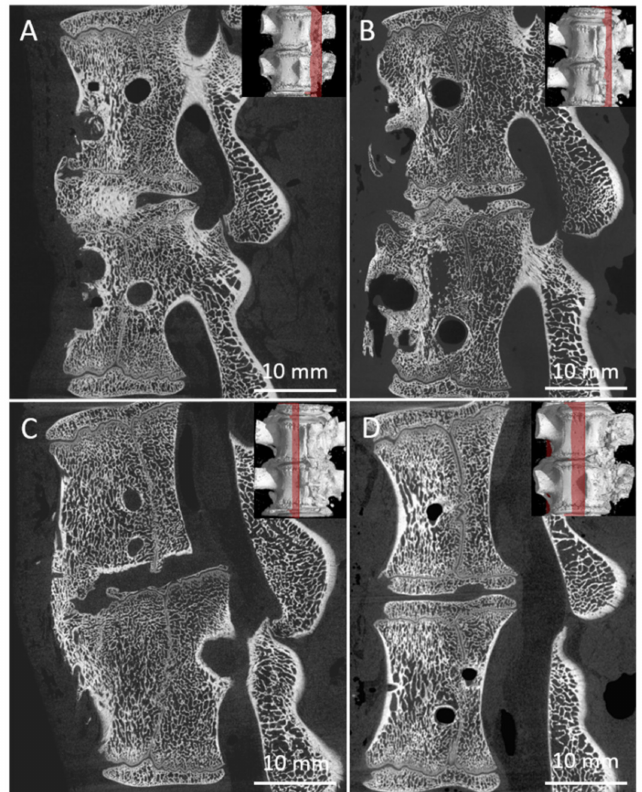
Figure 8. Examples of bone graft samples sorted into groups according to the quality of the fusion Grade I, II, III, IV, respectively. ( A ) fusion is visible and entirely joins the vertebra in the area of the bone graft, ( B ) fusion in the area of the bone graft is presented, but it is not completed, ( C ) fusion of the vertebras is visible but it is not in the area of bone graft, ( D ) no fusion observed.